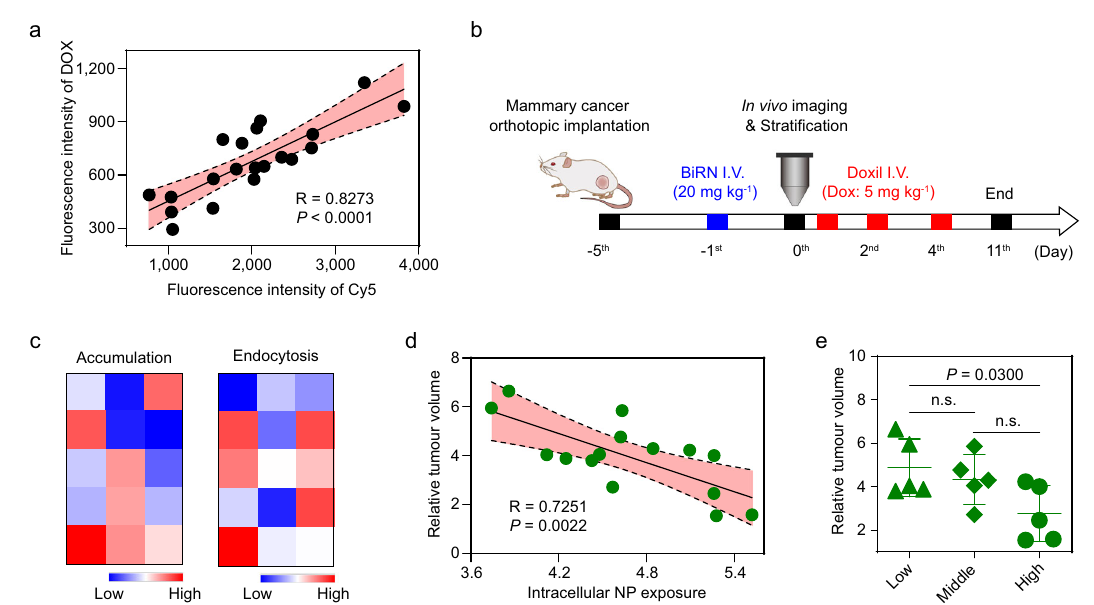
Fig. 6 BiRN predicts the therapeutic ef fi cacy of Doxil. a Correlation between signals of BiRN (Cy5, 20 mg kg − 1 ) and Dox (5 mg kg − 1 ) in tumour by fl ow cytometry ( n = 20 biologically independent mice) at 24 h post-injection of BiRN and Doxil. R and P values were derived using a simple linear regression model. The error band in red shows the 95% con fi dence intervals of the fi tted line by two-sided Student t -test analysis. b Schematic of BiRN technology to predict Doxil response in 4T1 orthotopic tumour model. c Heat map shows the heterogeneity of nanoparticle accumulation and endocytosis amount in 4T1 tumours for predicting Doxil response ( n = 15 biologically independent mice). d Correlation between intracellular nanoparticle signal and 4T1 tumour progression presented as relative tumour volume ( n = 15 biologically independent mice). R and P values were derived using a simple linear regression model. The error band in red shows the 95% con fi dence intervals of the fi tted line by two-sided Student t -test analysis. e Intracellular nanoparticle signal strati fi ed tumours into low, medium, or high tumour internalisation groups. Tumour response to Doxil showed signi fi cant differences between high and low group ( n = 5 biologically independent mice). * P = 0.0300, n.s. not signi fi cant, two-sided Student t